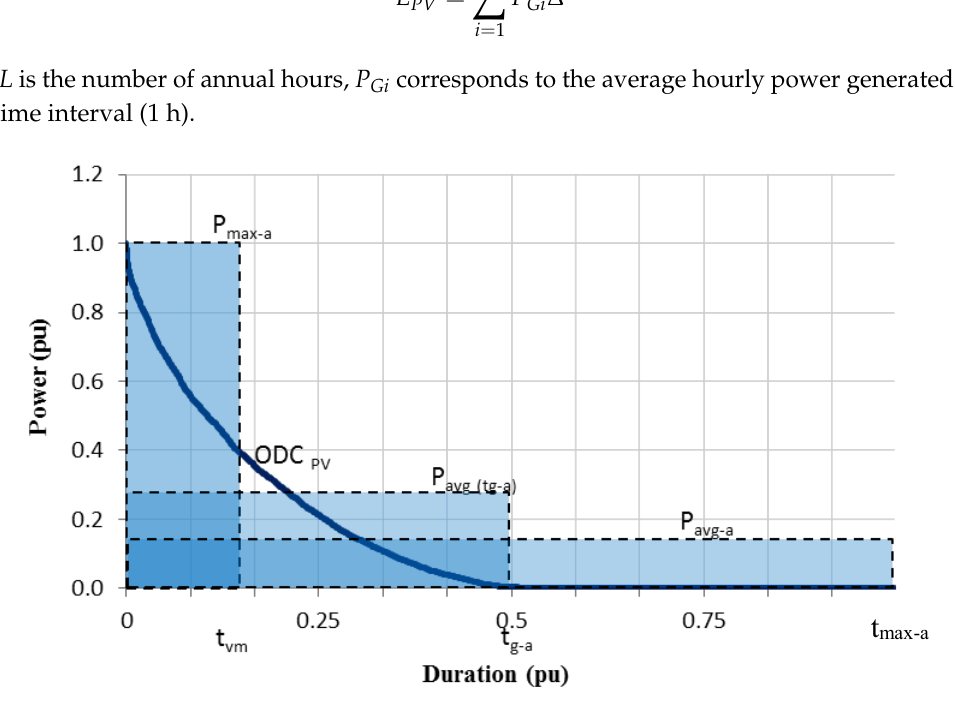
Figure 5. ODC PV and their equivalent rectangular areas.